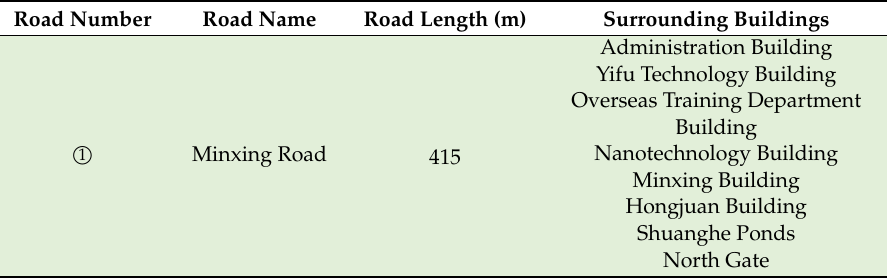
Figure 3. Wangjiang Campus remote sensing image of Sichuan University in 2018. The nine selected roads have been marked in yellow. Table 1. Road information.